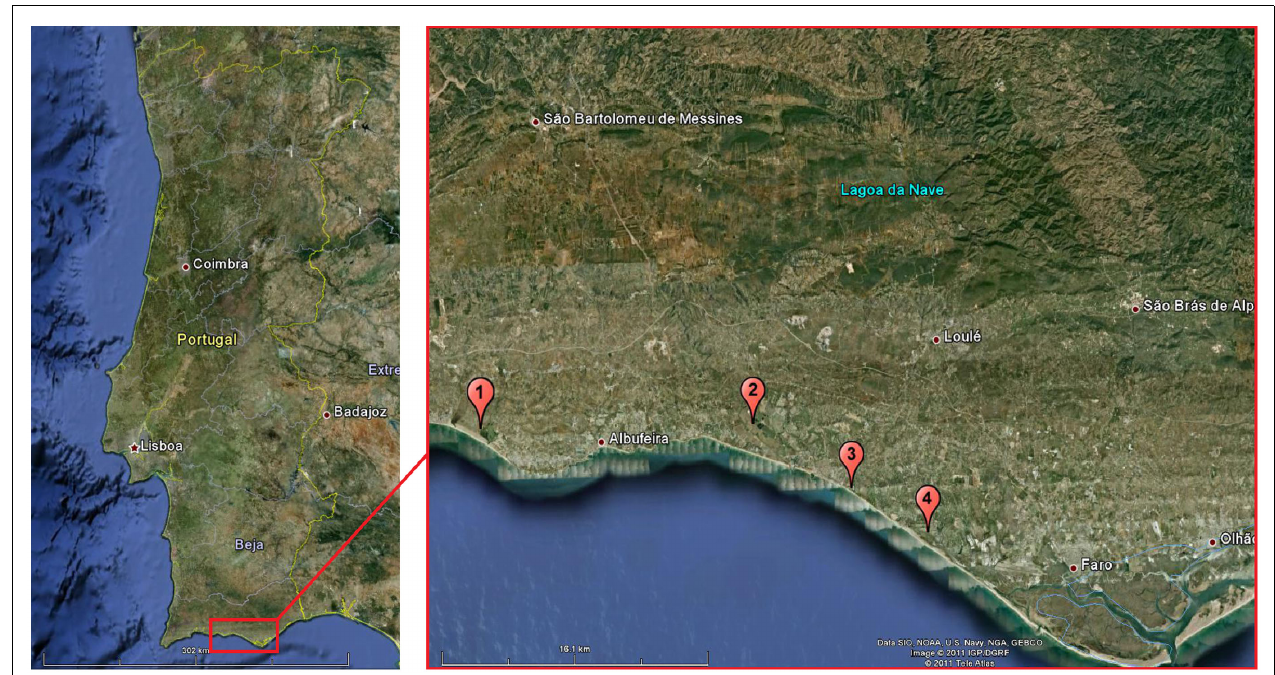
LagoonAlmargem (Quarteira); (4, e) Lagoon Dunas Douradas, (4, f) Lagoon Garrão, and (4, g) Lagoon Quinta das Salinas (Garrão). Distance between 1 and 4 is ca.